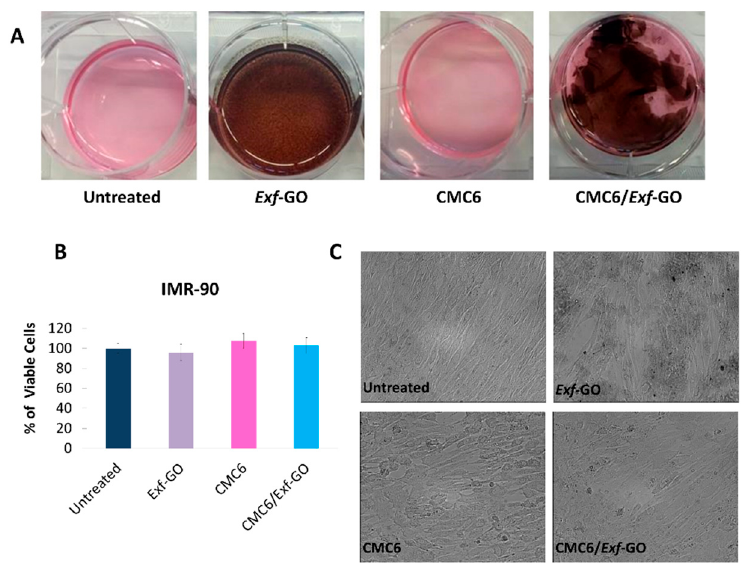
Figure 9. The effect of CMC6/ Exf -GO treatment on normal fibroblasts IMR-90 cell line; ( A ) details of the culture plates in which the fibroblasts not exposed (untreated) or exposed to Exf -GO, CMC and CMC6/ Exf -GO were grown; ( B ) graph showing the % of viable cells with respect to untreated ones, counted by trypan blue exclusion method; and ( C ) optical microscopy images of normal fibroblasts either not exposed (untreated) or exposed to GO, CMC and CMC6/ Exf -GO for 48 h, where no morphological changes were observed. Magnification 200×.